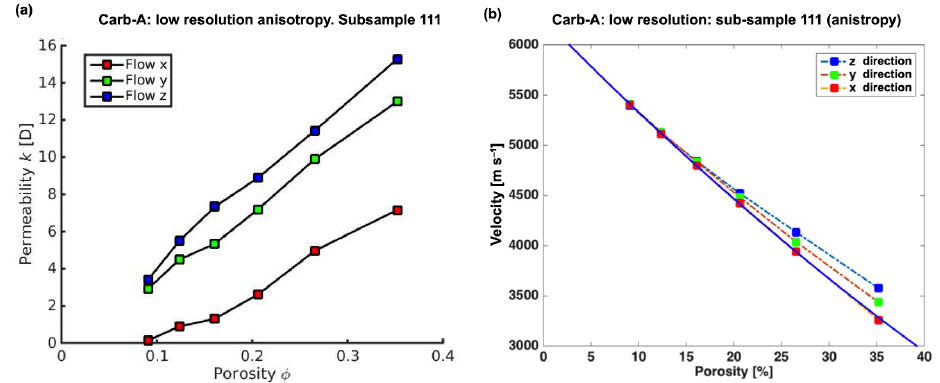
Figure 11. Left-hand side: intrinsic permeability for subvolume 111 of Carb-A low resolution. Permeability calculated from flow simulated in x , y , and z directions. Right-hand side: P -wave velocities for all propagation directions of the same subsample. The solid line is the velocity trend given by Eq. (4). The moderate anisotropy visible in permeability is not present for the